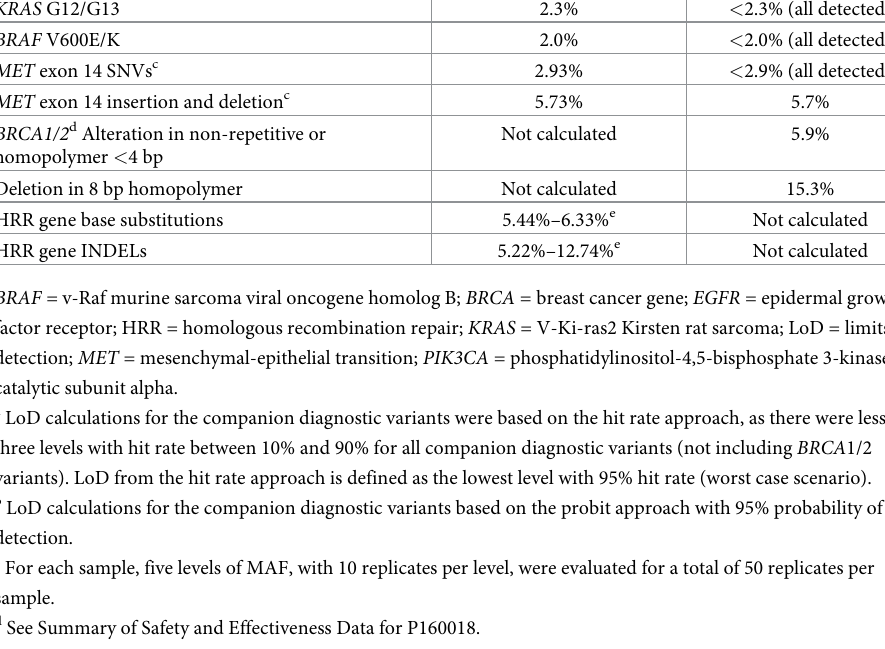
Table 7. Sample validation for F1CDx companion diagnostic claims. Alteration